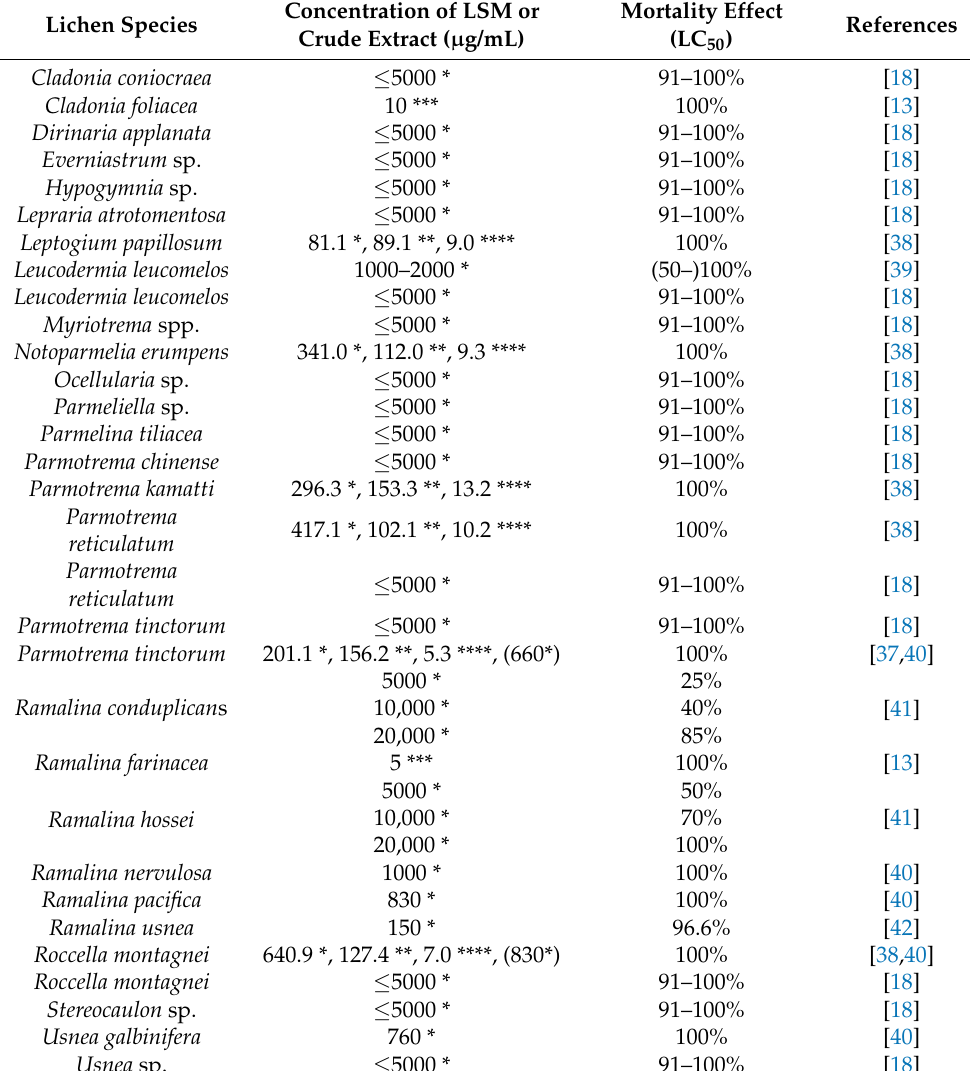
Table 3. Applied concentration of the crude lichen extract or LSM extracted from the given lichen species and mortality of mosquitoes ( Aedes and Culex ) connected to tests carried